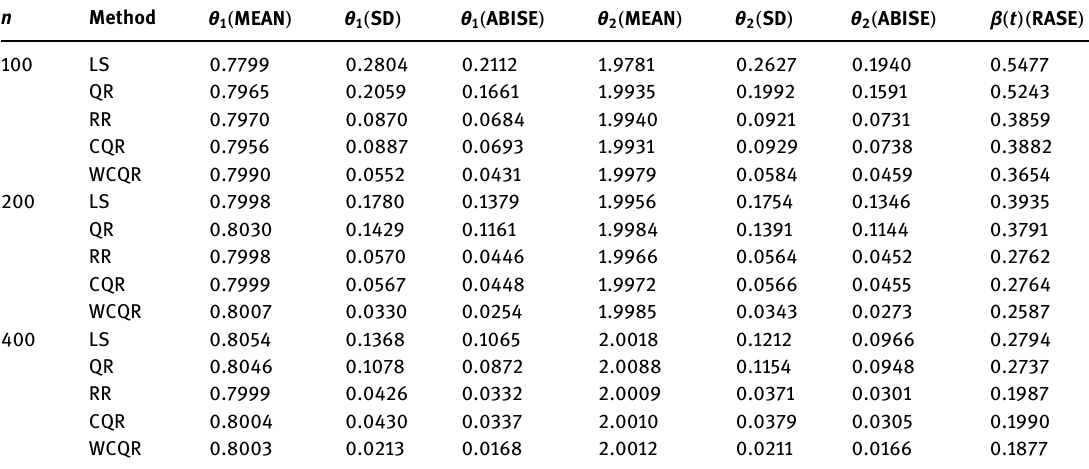
Table 3: Simulation results for θ with F ( 4, 6 ) random error